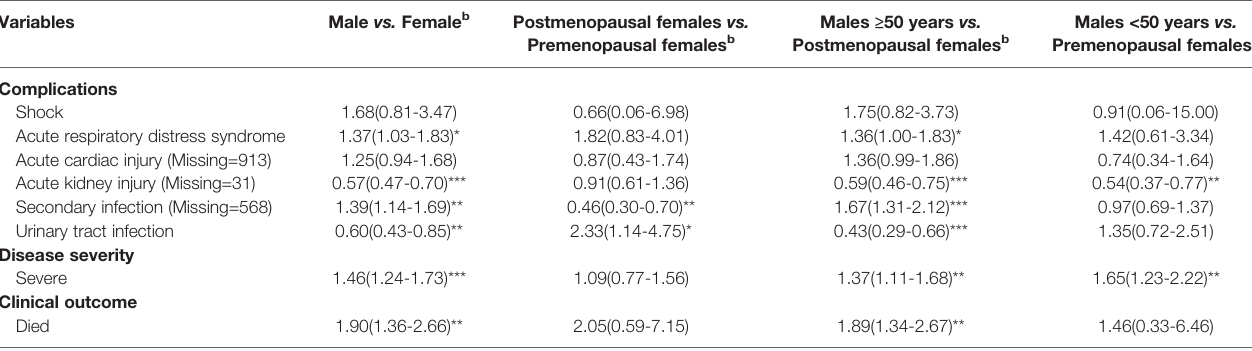
TABLE 3 | Multivariable logistic regression analysis of associations of groups with outcomes a .